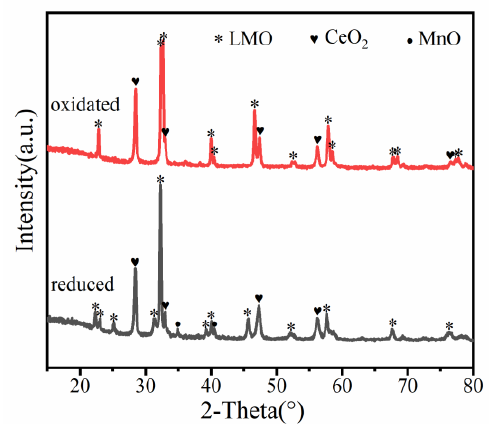
Figure 9. XRD patterns of 0.3LCMO after 20 continuous cycles test and regeneration.